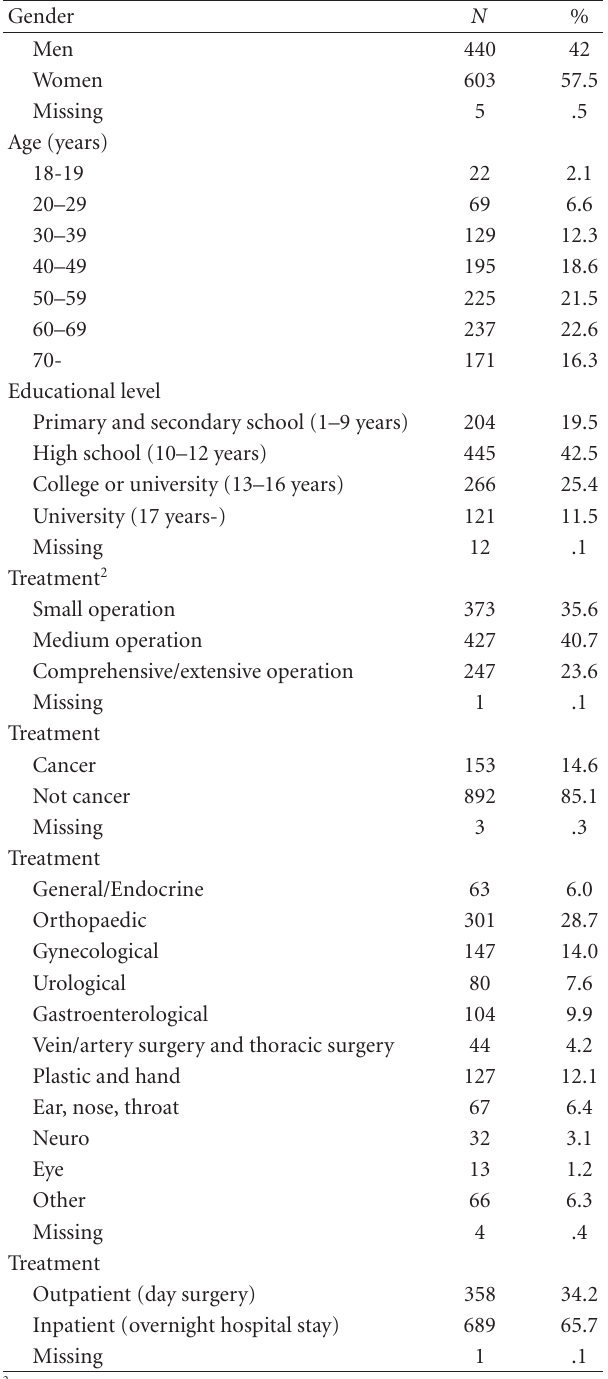
Table 2: Demographic characteristics of study sample of